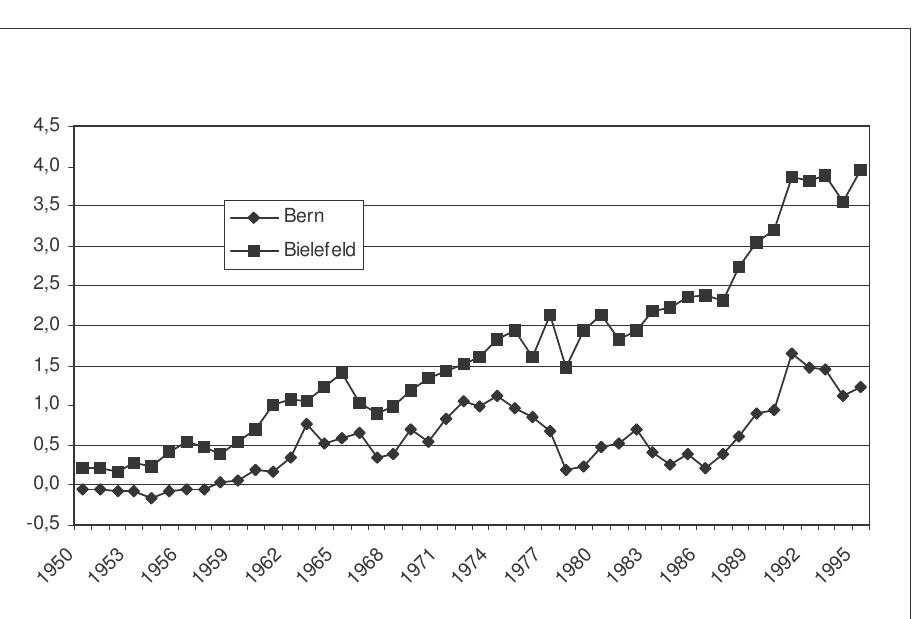
Figure 7. Public transport: comparison Berne - Bielefeld, deficits: in SFR/DM 10 million in prices from 1985)